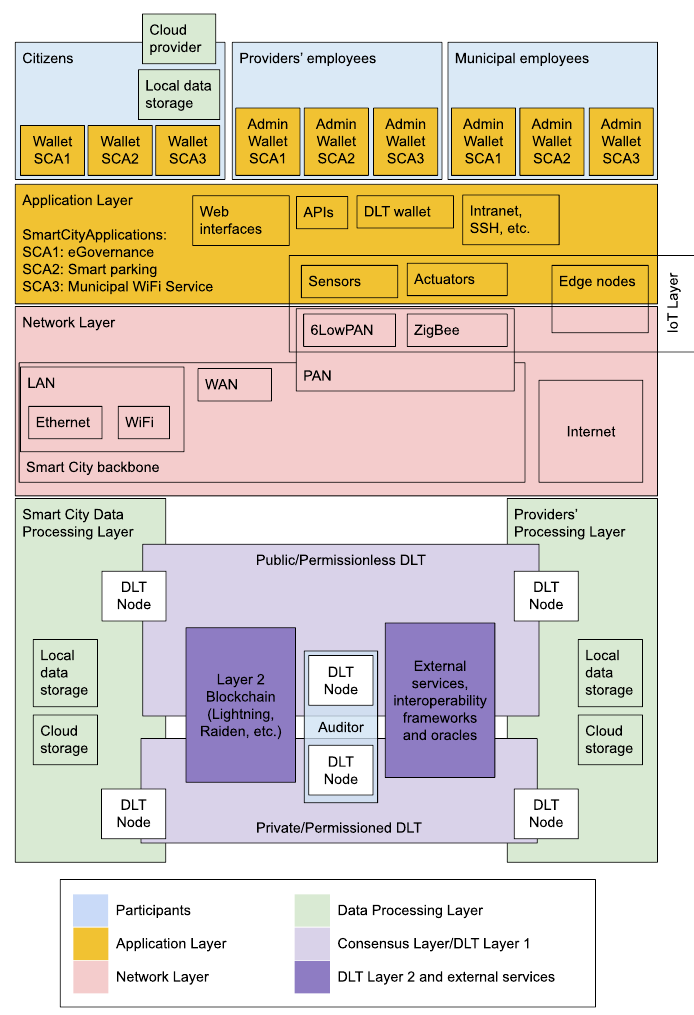
Figure 1. User-centric smart city framework based on DLT.